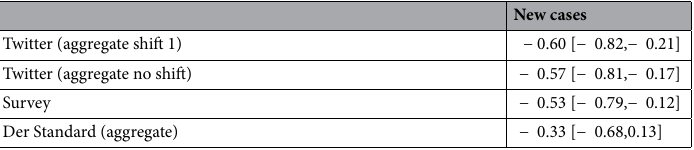
Table 2. Correlation of survey, aggregate Twitter sentiment and aggregate Der Standard sentiment with the number of new COVID-19 cases. Figure S3 shows scatter plots for each of the variables and new COVID-19 cases.